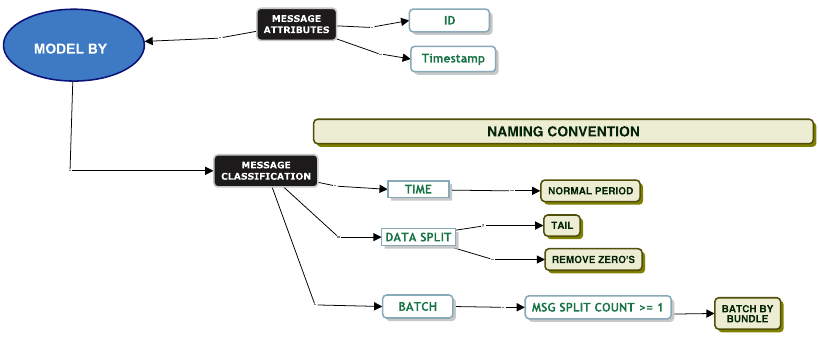
Figure 12. Batch by bundle classification